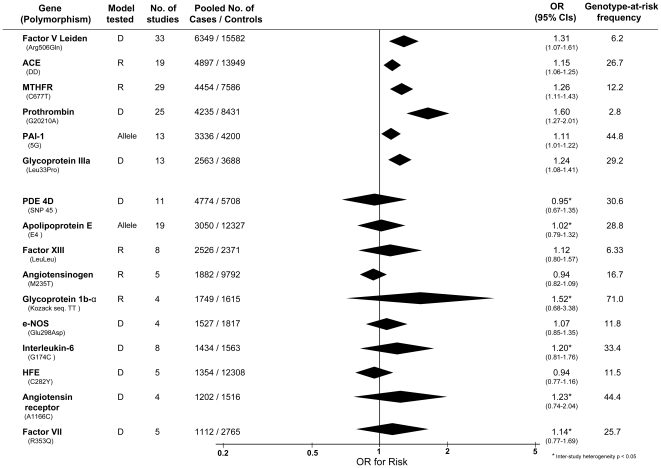
Summary of meta-analyses testing associations of candidate genetic polymorphisms with ischemic stroke.Table reports genetic model tested (D – dominant; R – recessive); numbers of studies; numbers of pooled cases and controls; ORs with 95% confidence intervals, and at-risk genotype frequency.